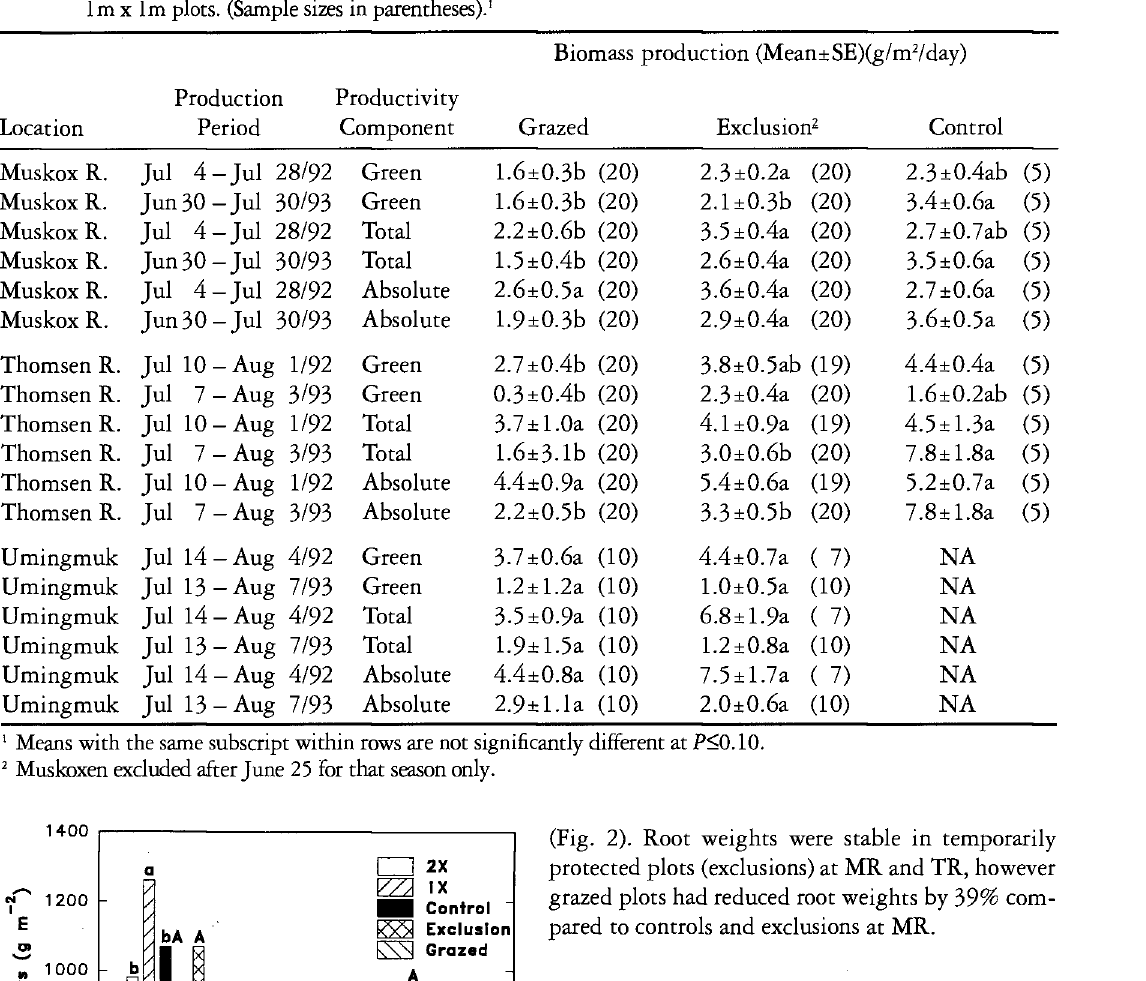
(Fig. 2). Root weights were stable in temporarily protected plots (exclusions) at MR and TR, however grazed plots had reduced root weights by 39% com pared to controls and exclusions at